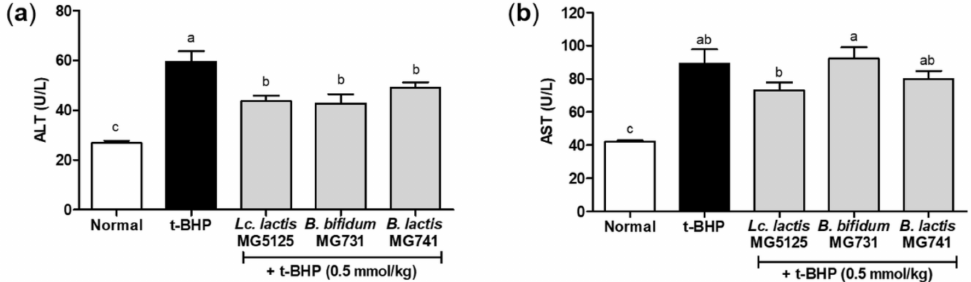
Figure 4. ( a ) ALT and ( b ) AST levels in the serum of t -BHP-induced C57BL/6 mice pretreated with probiotics for 14 days. The data represent the mean ± SEM ( n = 7). Different letters among columns indicate significance at p < 0.05, as determined by Duncan’s test.